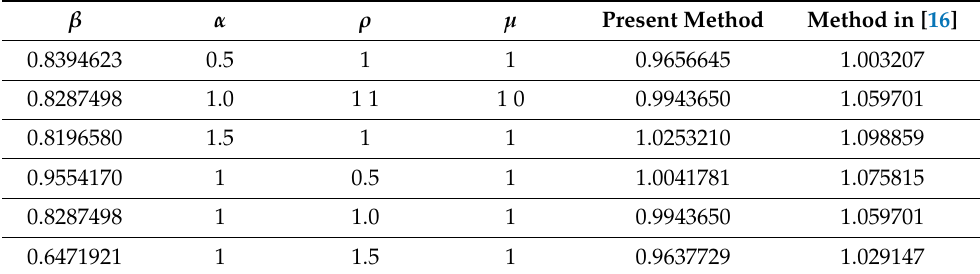
Table 3. Comparison of the effectiveness factor τ with different choices of the parameters.